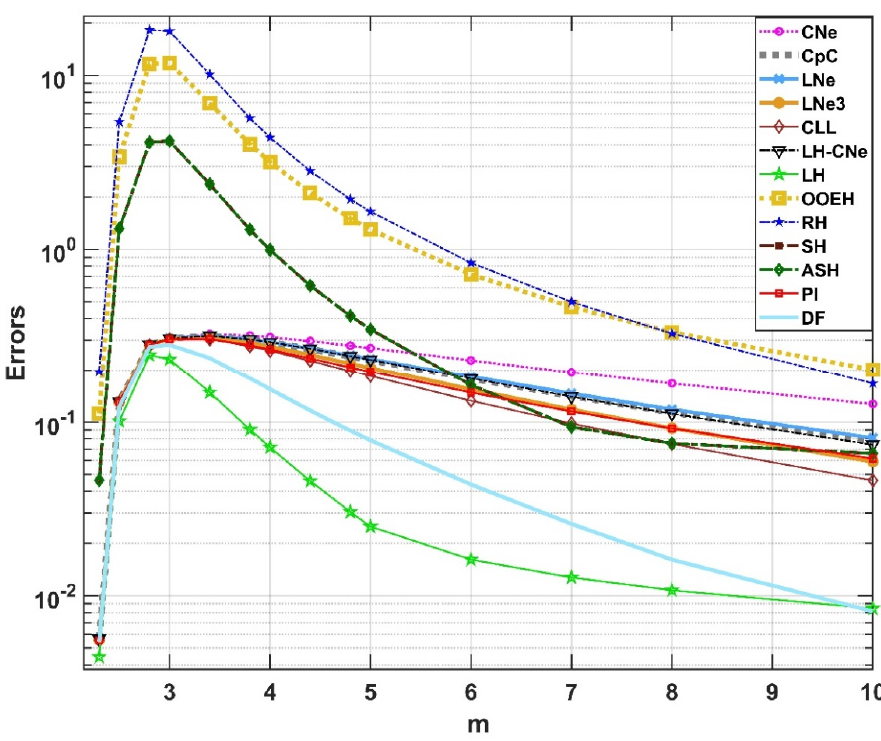
Figure 11. The L ∞ errors as a function of the parameter m for an equidistant mesh (Experiment 3). RK4 is not present in the figure because it is unstable for the examined time step size.